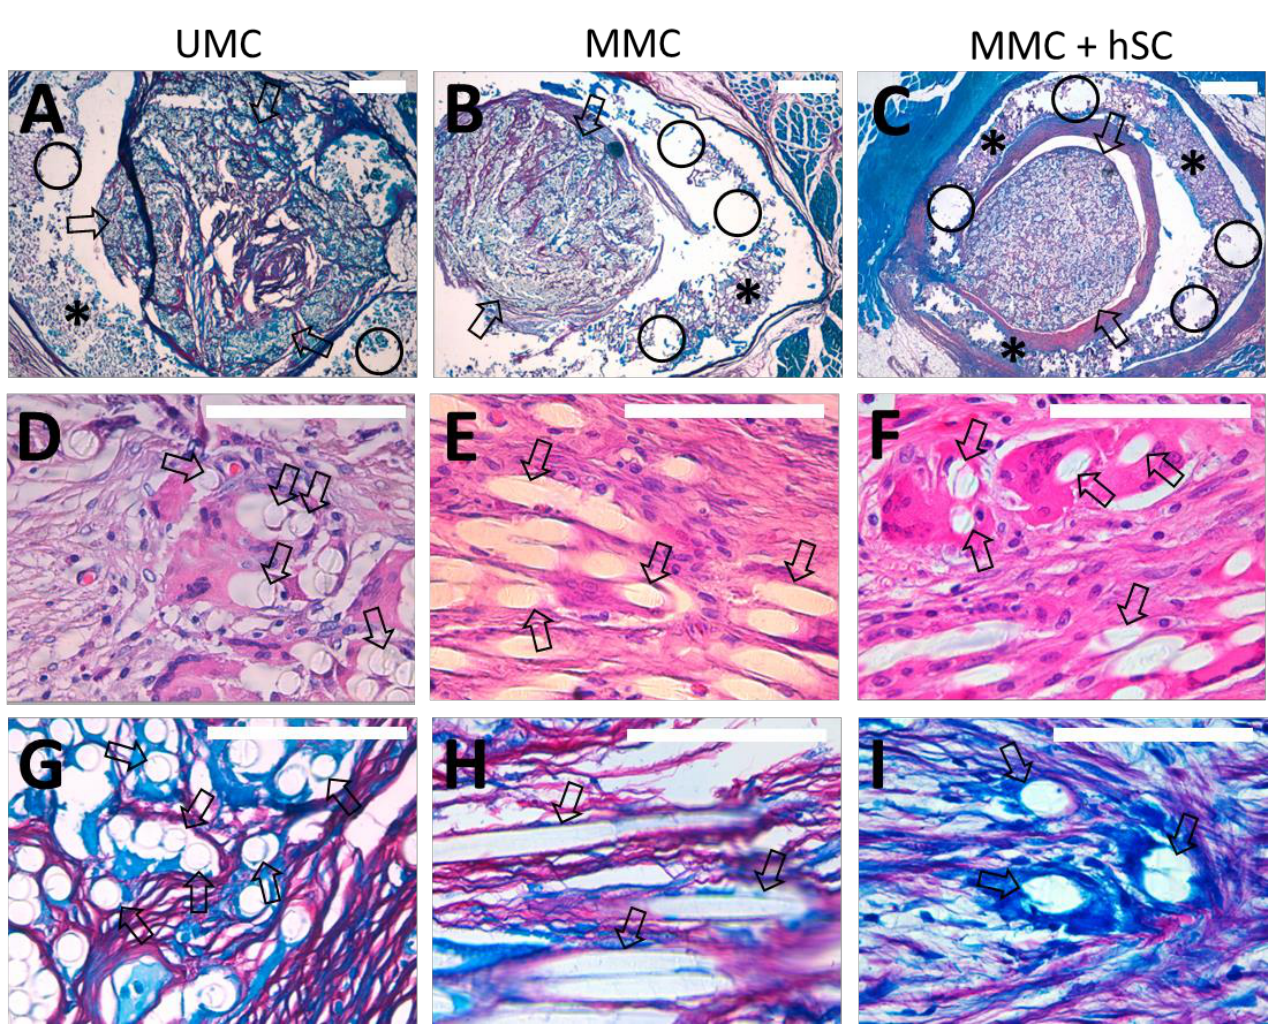
Figure 8. Luxol fast blue staining of tissue samples from the three experimental groups 6 months after surgery at the distal portion ( A – C ) and details of hematoxylin and eosin staining ( D – F ), as well as Luxol fast blue ( G – I ), with the aim of studying the interaction of PLA microfibers with the surrounding tissue. ( A – C ) Luxol fast blue stains (4 × ) of cross sections showing the distribution of PLA microfibers (marked with arrows) within the HA conduit (marked with *). The HA conduit walls present signs of incipient degradation in all experimental groups, since their porous structure presents voids and breaks in continuity (marked with circles). ( D – F ) Hematoxylin-eosin staining (63 × ) showing the distribution of the tissue and the PLA microfibers for the UMC, MMC and MMC + hSC groups, respectively. Some voids are observed between the tissue and the PLA microfibers for the UMC ( D ) and MMC ( E ) groups, whereas closer contact between the tissue and PLA microfibers is observed for the MMC + hSC group ( F ). ( G – I ) Luxol fast blue stains (63 × ) showing the interaction between PLA microfibers and myelinated nerve fibers (in dark blue), macrophages (in light blue) and collagen (in red) for the UMC, MMC and MMC + hSC groups, respectively. For the UMC ( G ) and MMC ( H ) groups, some voids are observed between myelinated nerve fibers and PLA microfibers, whereas a much closer distribution of myelinated nerve fibers and PLA microfibers without voids is appreciated for the MMC + hSC group ( I ). Scale bar = 500 µ m for 4 × images, 100 µ m for 63 ×